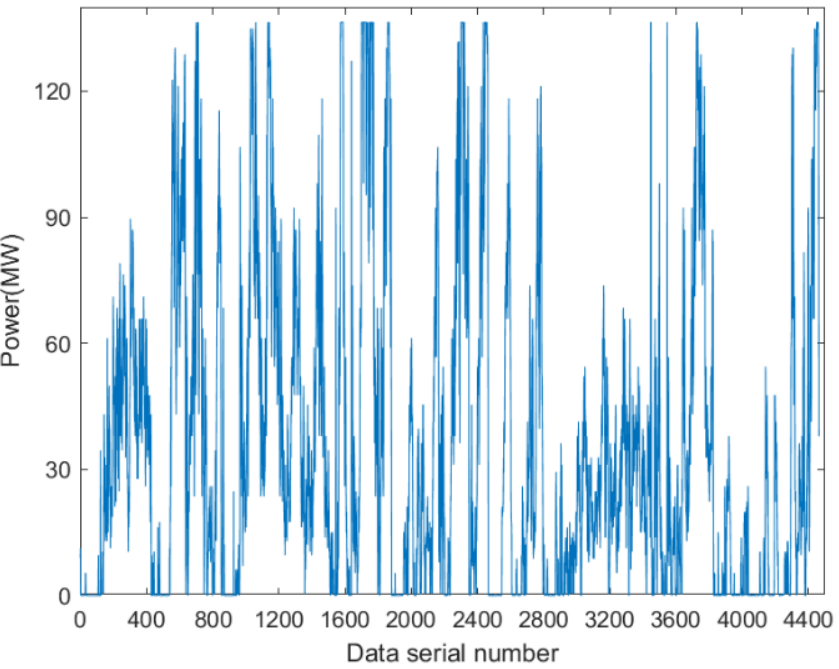
Figure 4. Historical data of wind power.